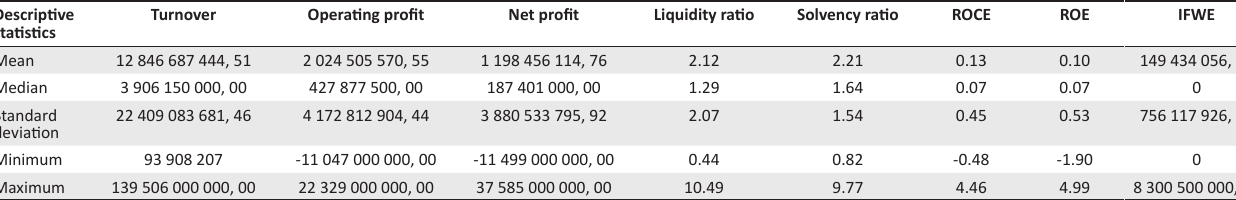
TABLE 2: Descriptive statistics: Business performance of total data set (2006–2014).